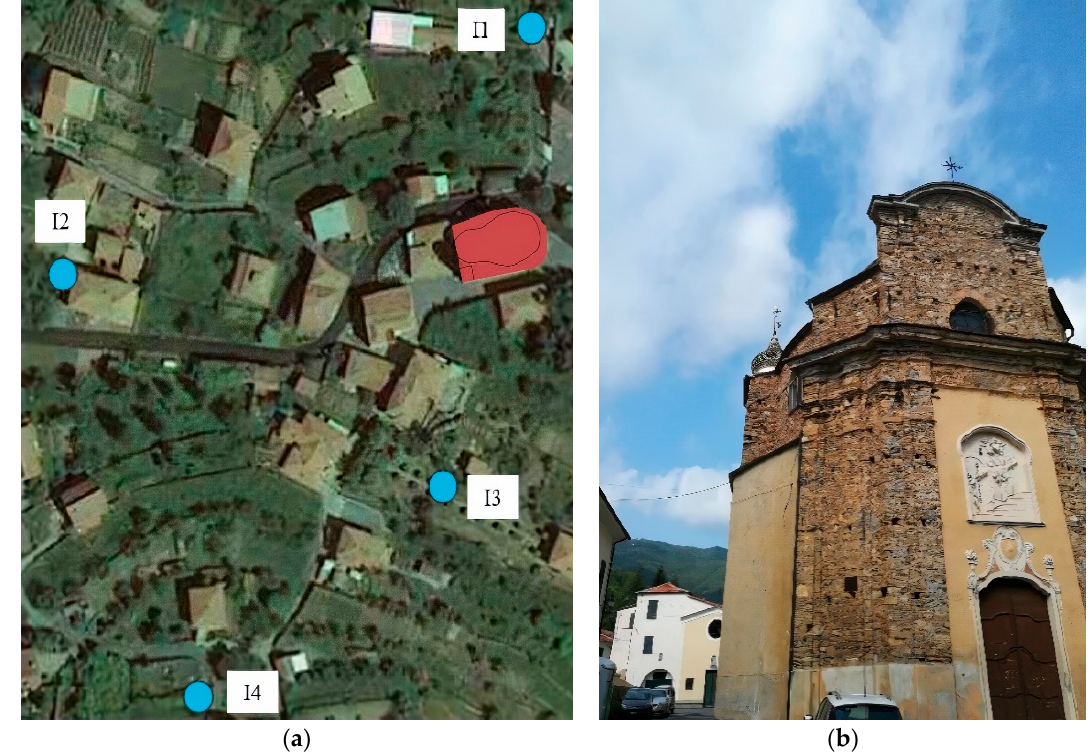
Figure 10. ( a ) Position of the church in Ville San Pietro; ( b ) Picture of the church.